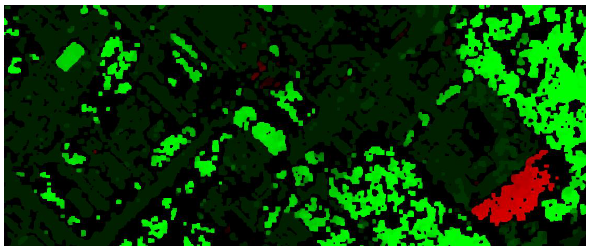
Table 1: Possible changes depending on classified areas, empty fields mean “no change”, v and ¯ v denote vegetation or non- vegetation, bld. stands for building low → low low → high high → low high → high v → v trees growed trees logged v → ¯ v harvested bld. erected trees logged planted